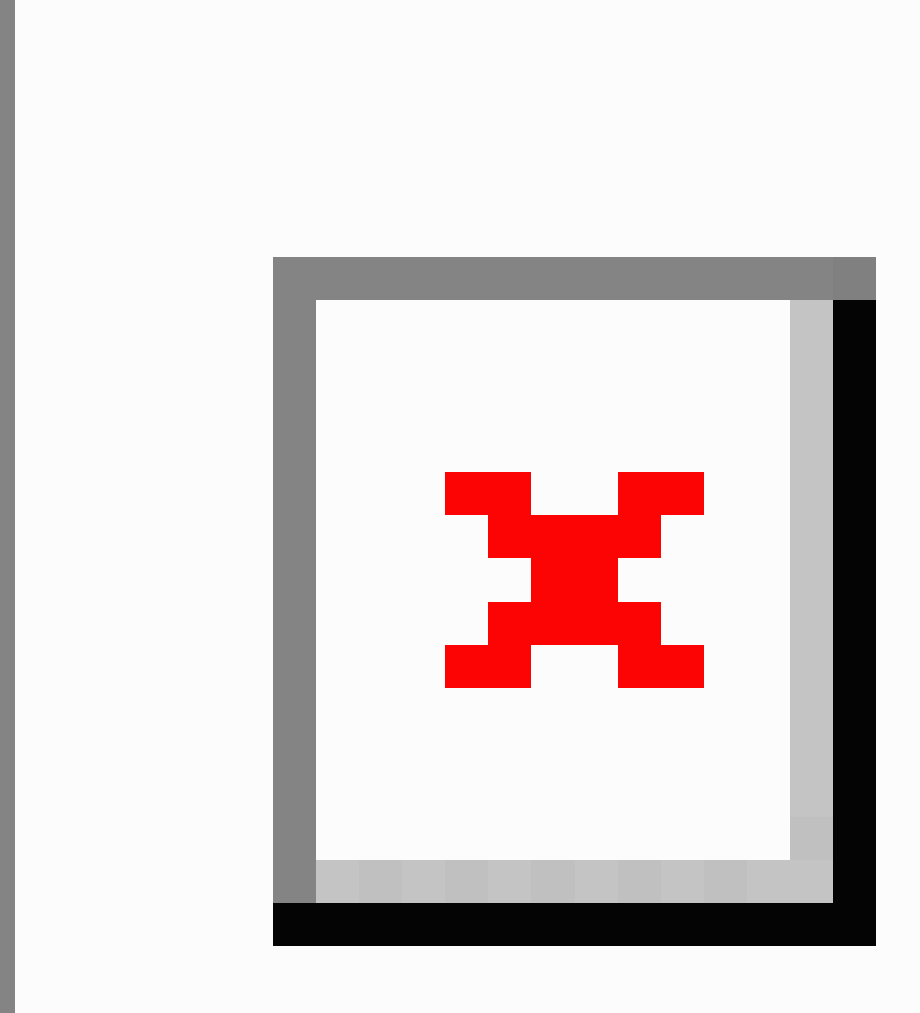
Figure 2. Search page to find available